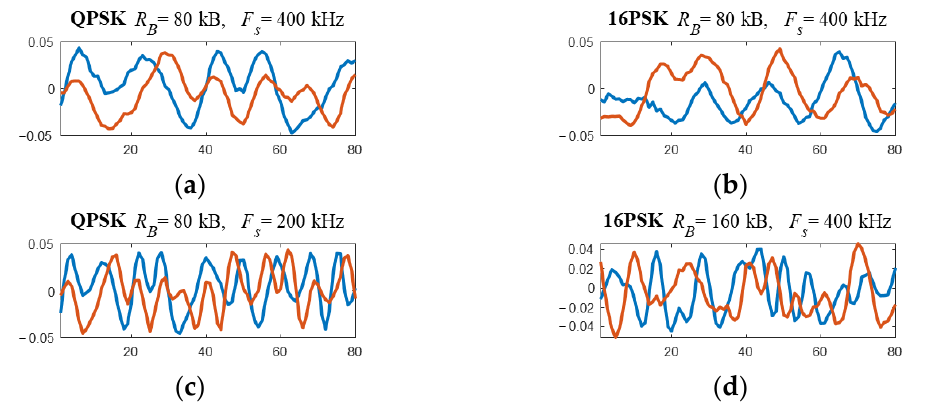
Figure 1. Signal examples with varying symbol rates ( R B ) at different sampling frequencies ( F s ). Red line represents I conponents and blue line represents Q components. ( a ) QPSK signal, whose R B is 80 k baud and F S is 400 kHz; ( b ) 16PSK signal, whose R B is 80 k baud and F S is 400 kHz; ( c ) QPSK signal, whose R B is 80 k baud and F S is 200 kHz; and ( d ) 16PSK signal, whose R B is 160 k baud and F S is 400 kHz.